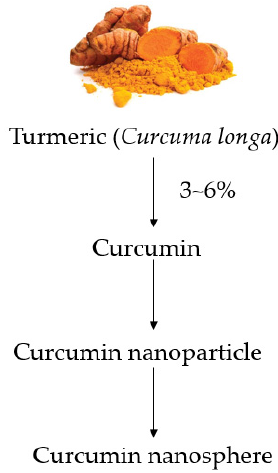
Figure 1. Outline of the production process from turmeric to curcumin